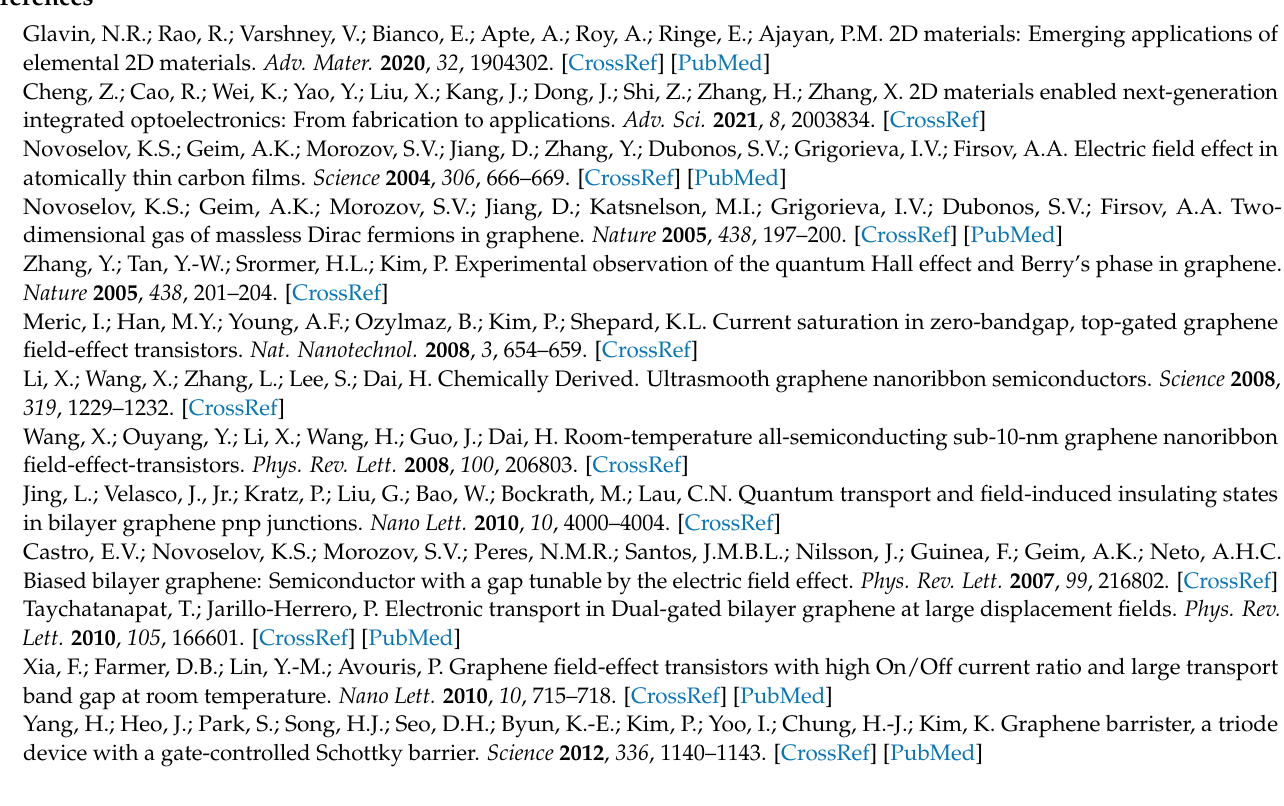
Figure S3: Schematic and electrical properties of MoS 2 field-effect transistor with Au/Ti